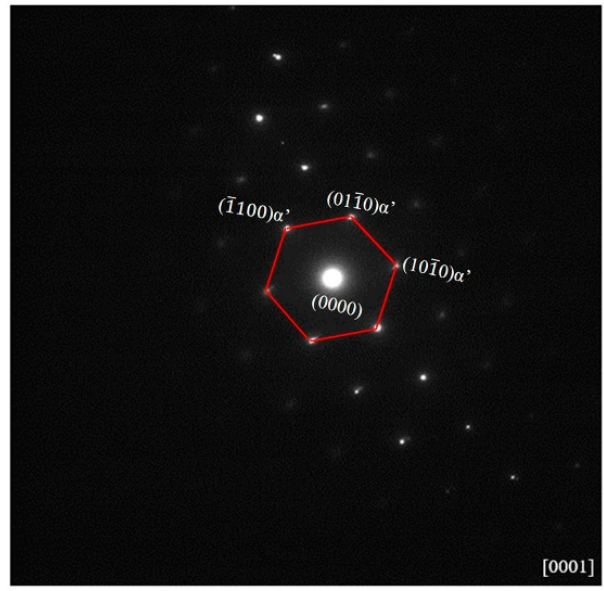
Figure 3. α ’ martensite phase selected area electron diffraction (SAED) patterns of the Zr-16Nb-xTi alloys.